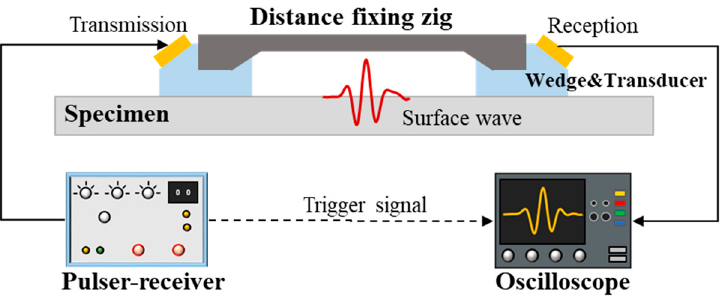
Figure 7. Surface wave velocity measurement set-up, in which the distance fixing zig holds the wedges to keep the surface wave propagation distance constant.